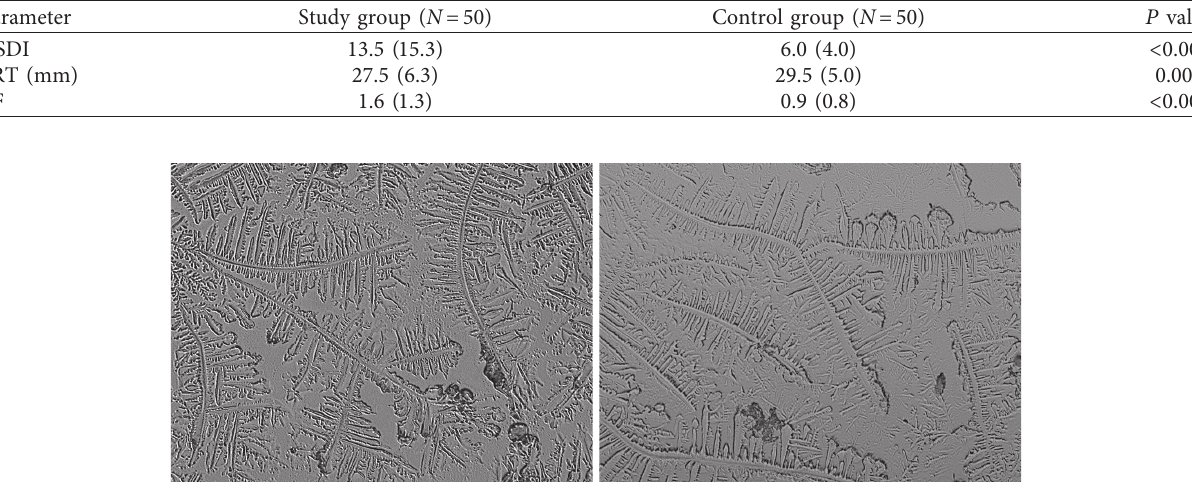
Figure 1: Representative TF images for two study group subjects.